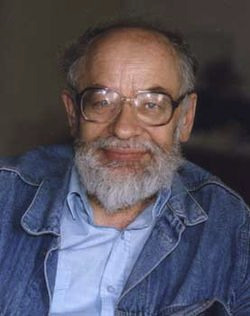
A.P. Khokhryakov